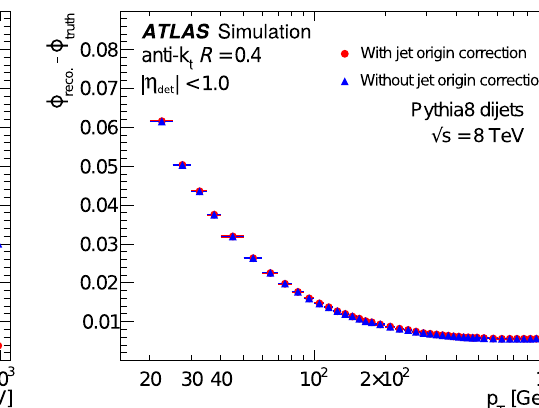
matching details) in simulated events and are shown both with (circles) and without (triangles) the jet origin correction, which adjusts the direc- tion of the reconstructed jet to point to the hard-scatter vertex instead of the geometrical centre of the detector